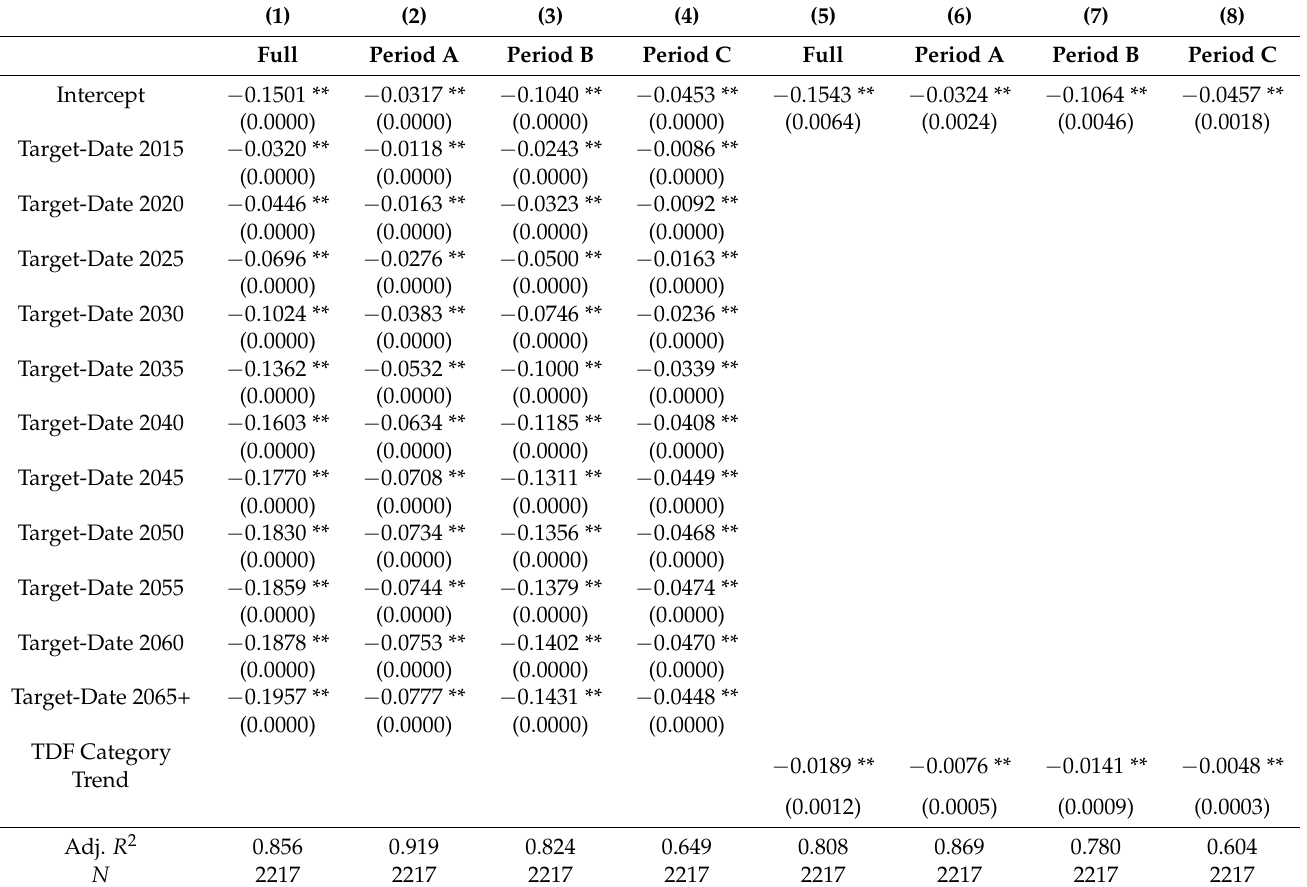
Table 5. Fund Category Drawdown Regressions.